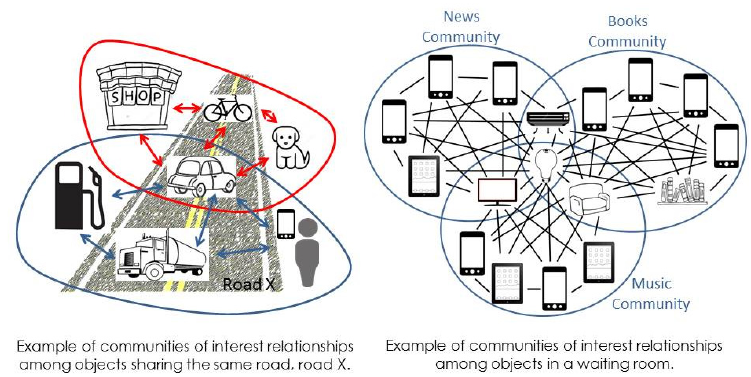
Figure 3. Examples of common interest relationship (CIR).